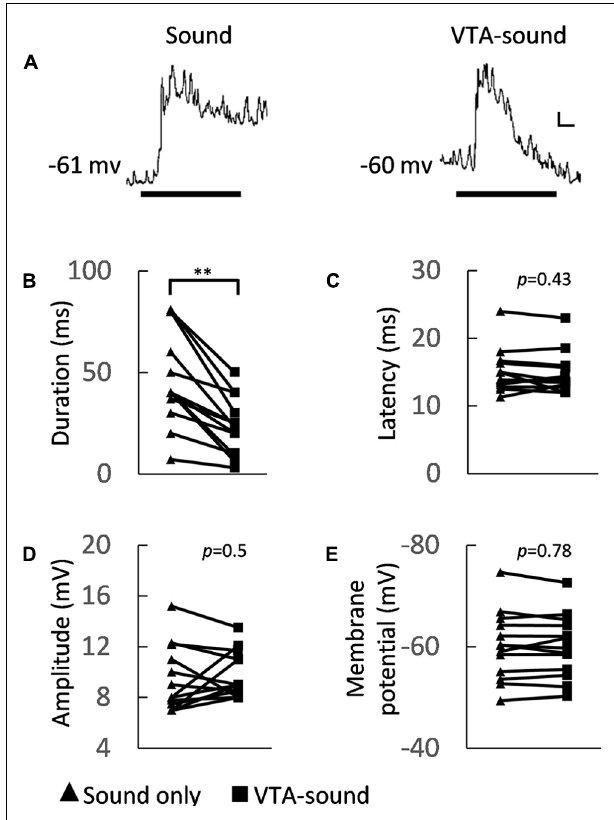
FIGURE 3 | Membrane potential characteristics ofA1 neurons under two groups of stimulation. (A) Averaged membrane potential from 13 recorded neurons (left: sound only group; right: pairedVTA-sound group). Thick black bar indicates the sound stimulation. Scale bar: 1 mV/10ms. (B) The duration of sound-evoked EPSP became shorter whenVTA was activated (sound only: 46.5 ± 23.1 ms; pairedVTA-sound: 23.2 ± 14.2 ms, ** p < 0.01, paired t -test, n = 13). (C) The peak latency showed no significant difference between two stimulation groups (sound only: 15.1 ± 3.3 ms; pairedVTA-sound: 14.8 ± 3 ms, p = 0.43, paired t -test, n = 13). (D) The amplitude of evoked EPSP (sound only: 9.4 ± 2.6 mV; pairedVTA-sound: 9.8 ± 1.8 mV, p = 0.5, paired t -test, n = 13) also did not change significantly. (E) The membrane potentials before and after the electric stimulation were measured and no significant difference was found (200 ms window; before: − 60.2 ± 6.8 mV; after: − 60.1 ± 6.2 mV, p = 0.78, paired t -test, n = 13; filled triangle: sound-only stimulation; filled square: pairedVTA-sound